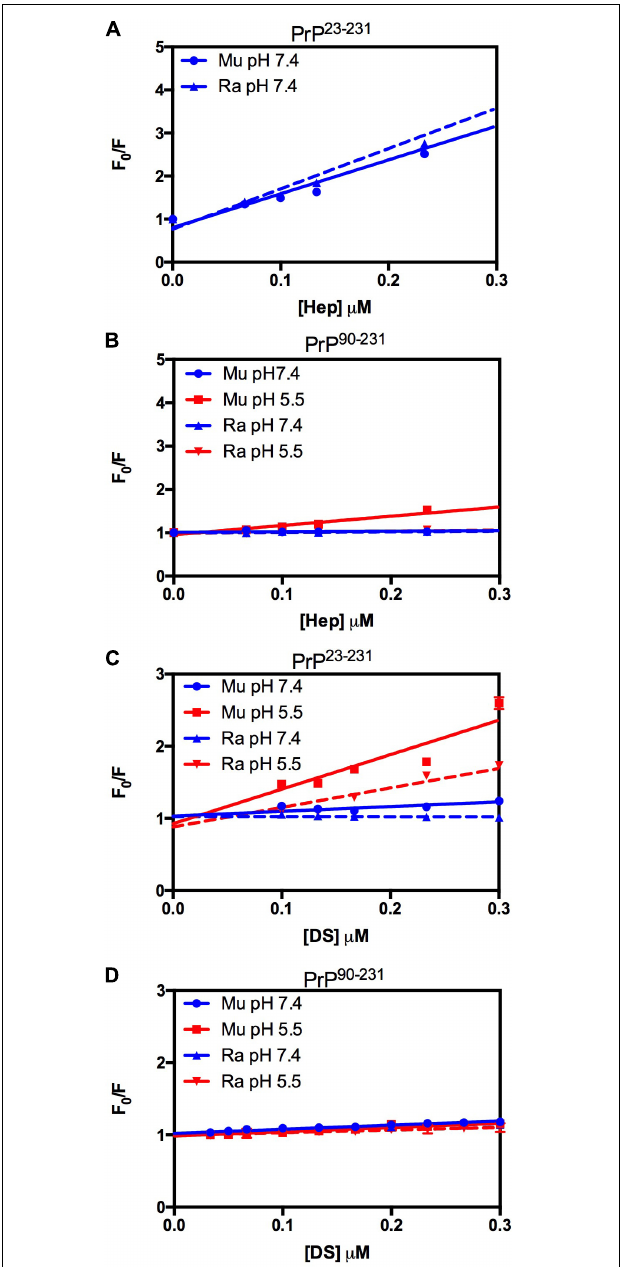
FIGURE 5 | RaPrP 23 − 231 interacts less with GAGs than MuPrP at pH 5.5, and the N-terminus is important for this interaction. Effect of increasing concentrations of Hep (A,B) and DS (C,D) on the fluorescence emission of PrP 23 − 231 (2 µ M) (A,C) and PrP 90 − 231 (2 µ M) (B,D) at pH 5.5 (red) and 7.4 (blue). Representative data from three experiments. The experiments were performed in 50 mM Tris buffer containing 100 mM NaCl at pH 7.4 or in 20 mM sodium acetate buffer containing 100 mM NaCl at pH 5.5. All experiments were performed at 25 ◦ C. The error bars represent the standard deviation of at least two independent experiments.